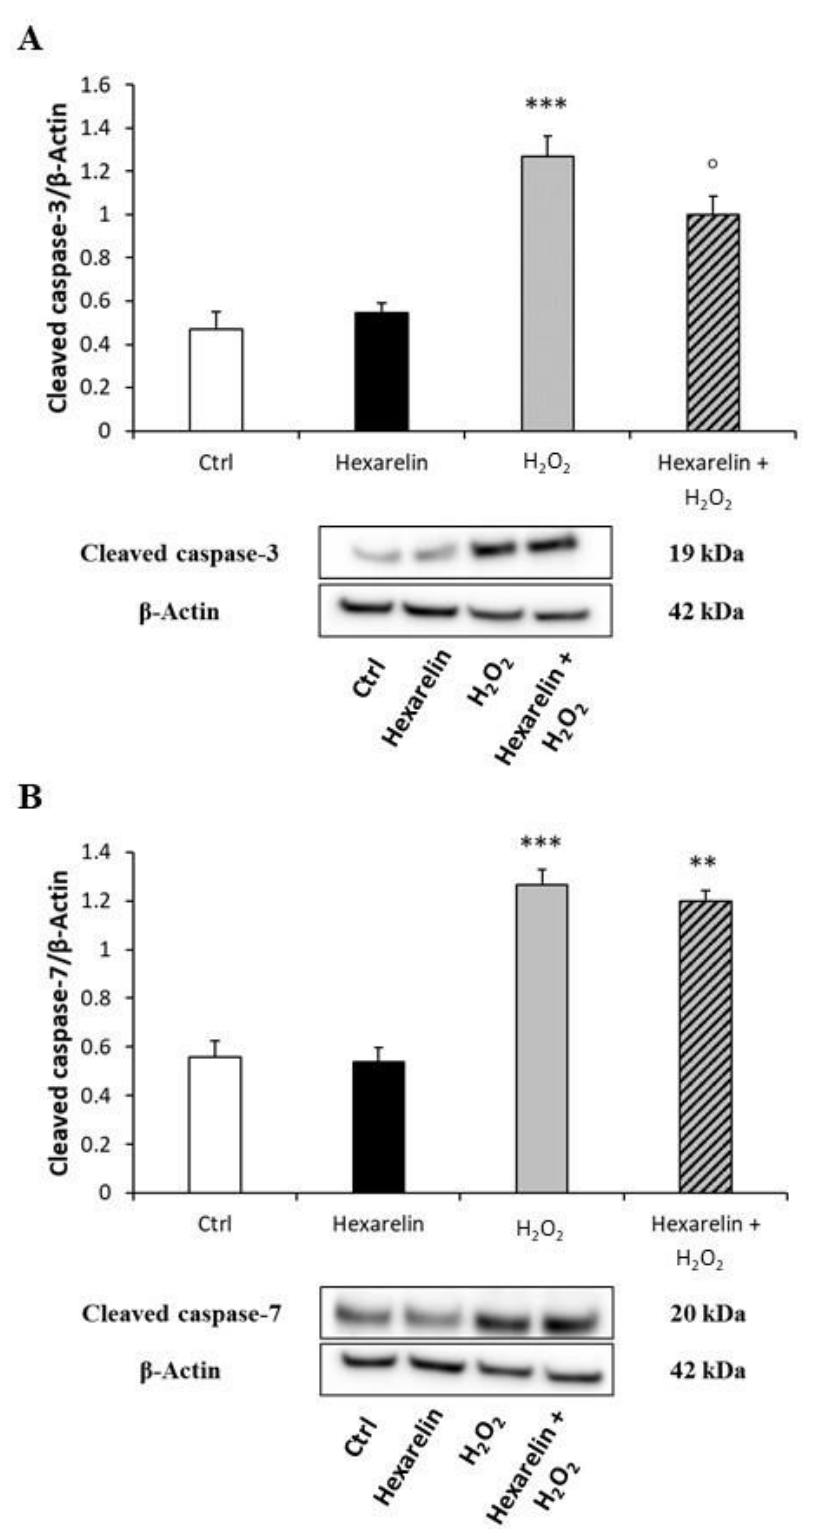
Figure 9. Hexarelin inhibits apoptotic pathway through caspase-3 inactivation. Neuro-2A cells were treated with or without hexarelin and H 2 O 2 for 24 h and assessed in Western blot for cleaved caspase- 3/ β -actin ( A ), and cleaved caspase-7/ β -actin ( B ). All assays were performed in at least 3 independent experiments ( n = 3). Statistical significance: ** p < 0.01, *** p < 0.001 vs. CTRL; ◦ p < 0.05 vs. H 2 O 2 .